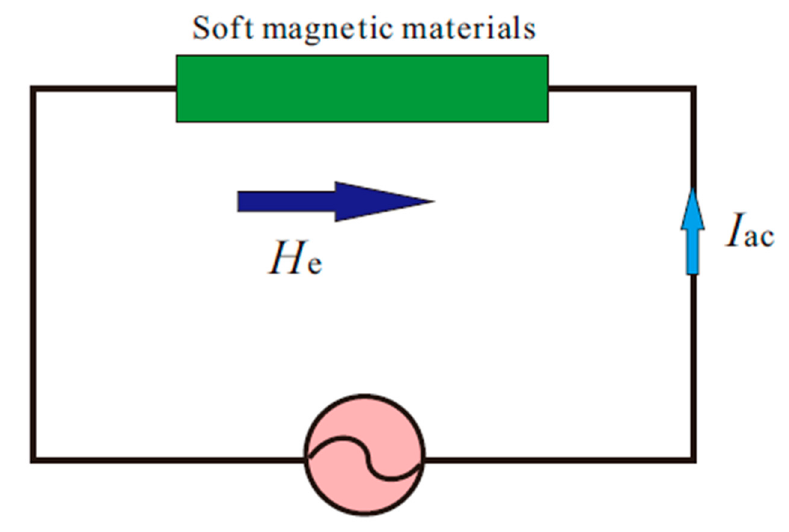
Figure 2. MI e ff ect in soft magnetic materials. Reproduced with permission from Elsevier Figure 2. MI effect in soft magnetic materials. Reproduced with permission from Elsevier [49] .